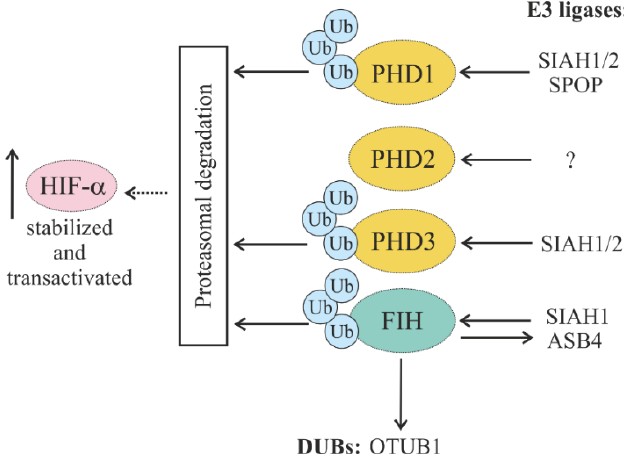
Figure 6. Schematic representation of HIF prolyl hydroxylases (PHDs) and factor-inhibiting HIF (FIH)) interplaying with E3 ligases and DUBs and their impact on HIF cellular abundance. Seven in absentia homologs ½ (SIAH1/2) and speckle-type POZ protein (SPOP) promote ubiquitylation of PHD1 and PHD3. So far, no E3 ligase is known for PHD2. Ankyrin repeat and SOCS box protein 4 (ASB4) and Otubain-1 (OTUB1) are hydroxylated by FIH.